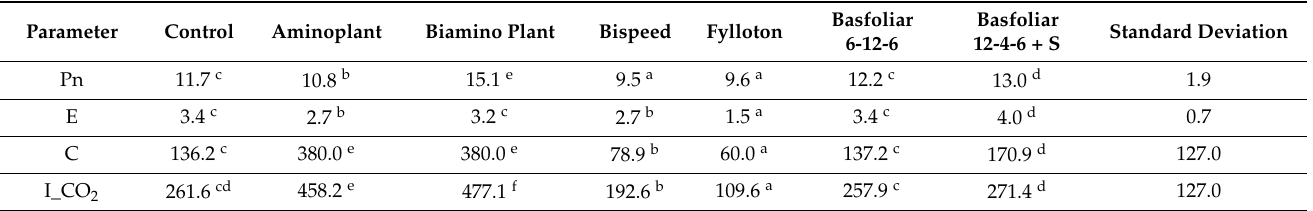
Table 7. Results of physiological parameters of M.9 rootstock stoolings depending on the tested